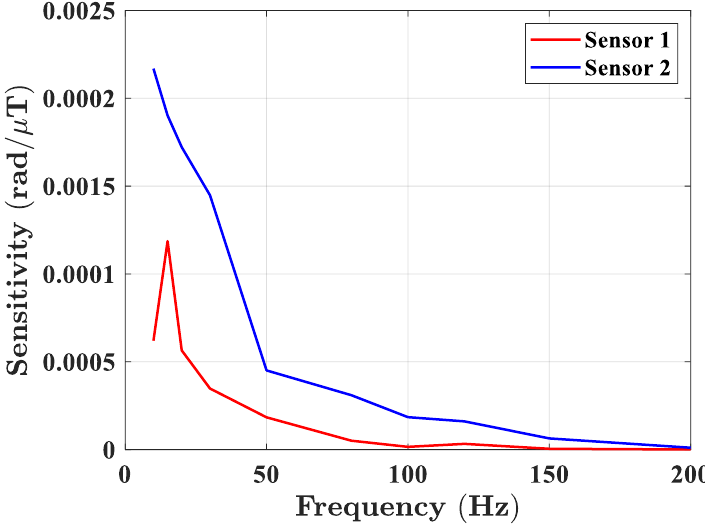
Figure 9. The frequency response of optical fiber magnetic field